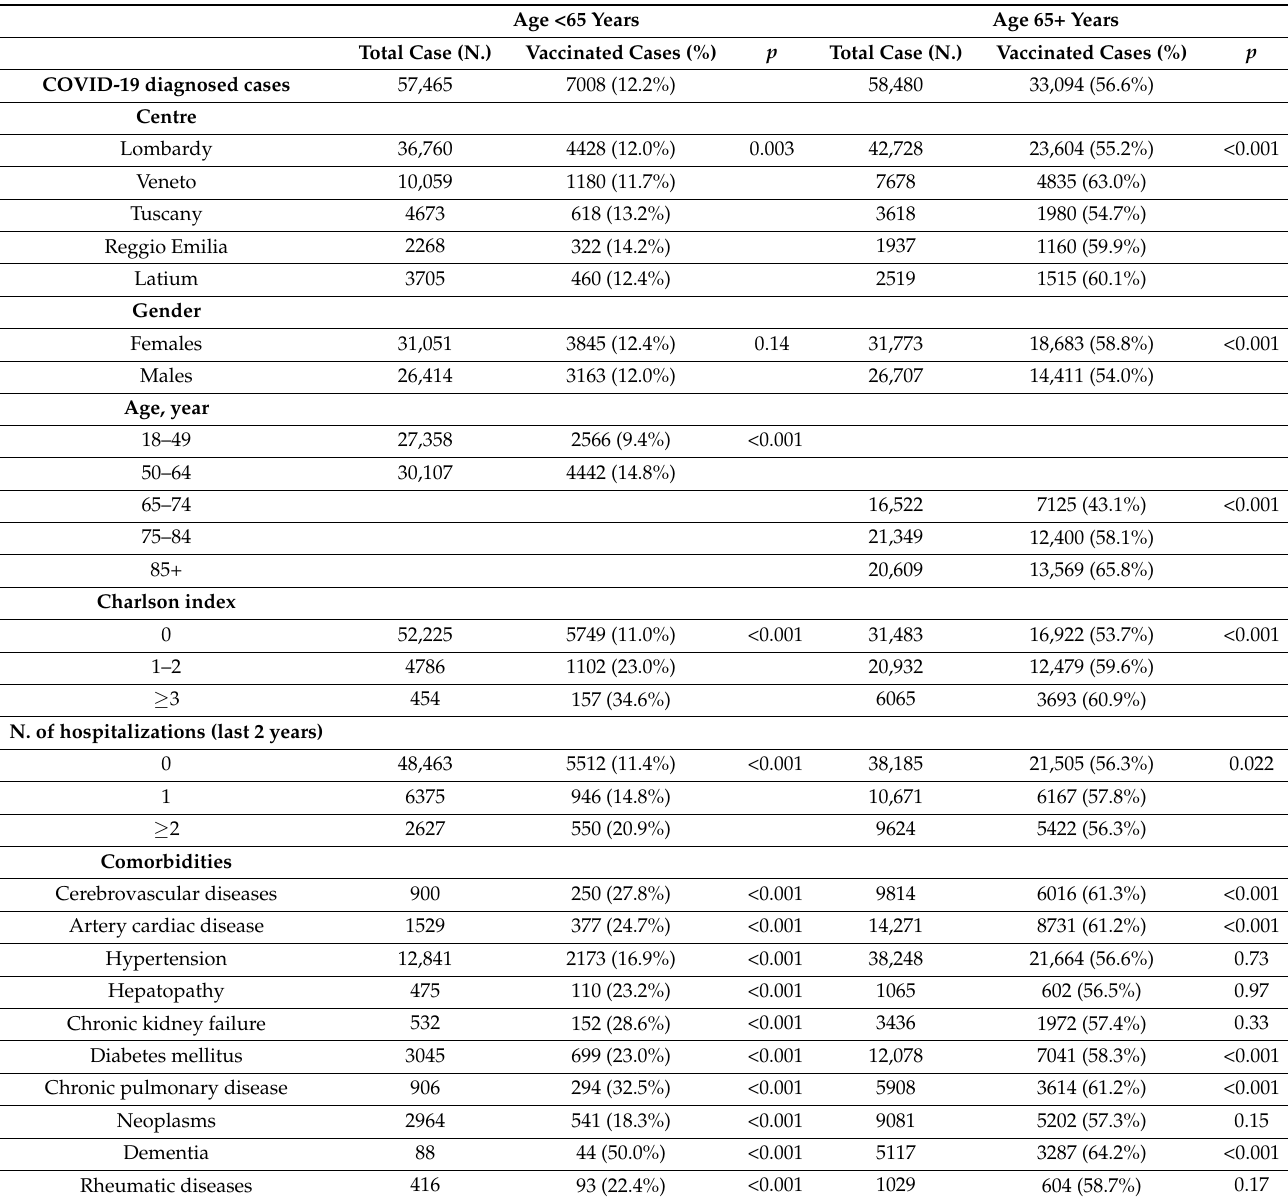
Table 2. Demographic and clinical characteristics of COVID SARS-COV-2 positive patients by age group and previous flu